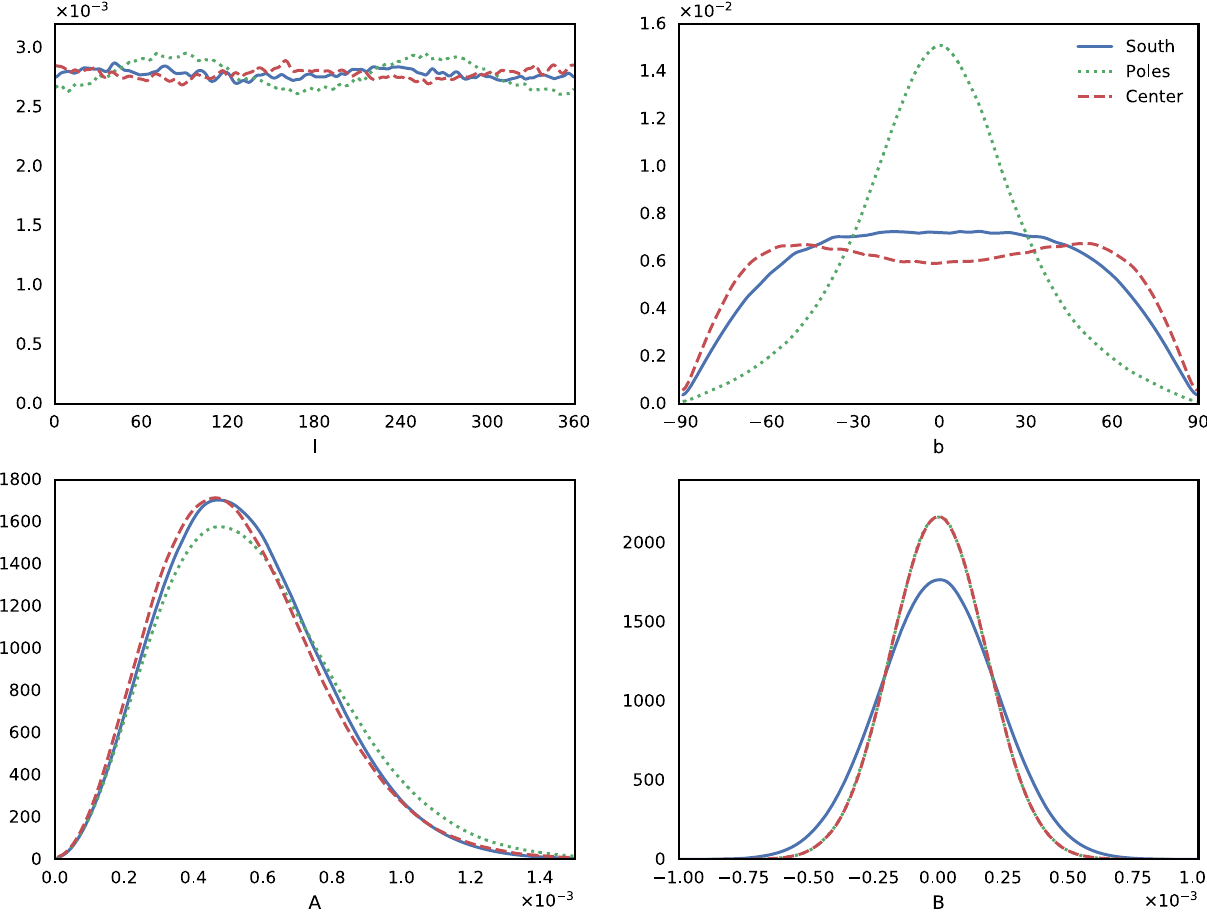
parameters and confidence levels. Furthermore, JLA data